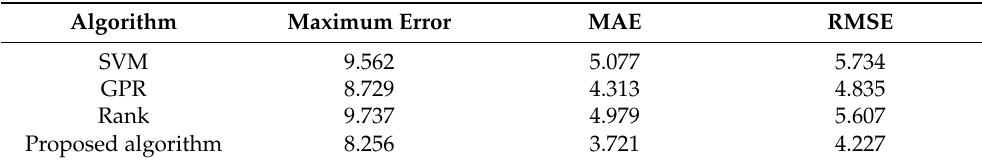
Table 3. The maximum errors, MAEs, and RMSEs of SVM, GPR, rank, and the proposed algorithm (m).